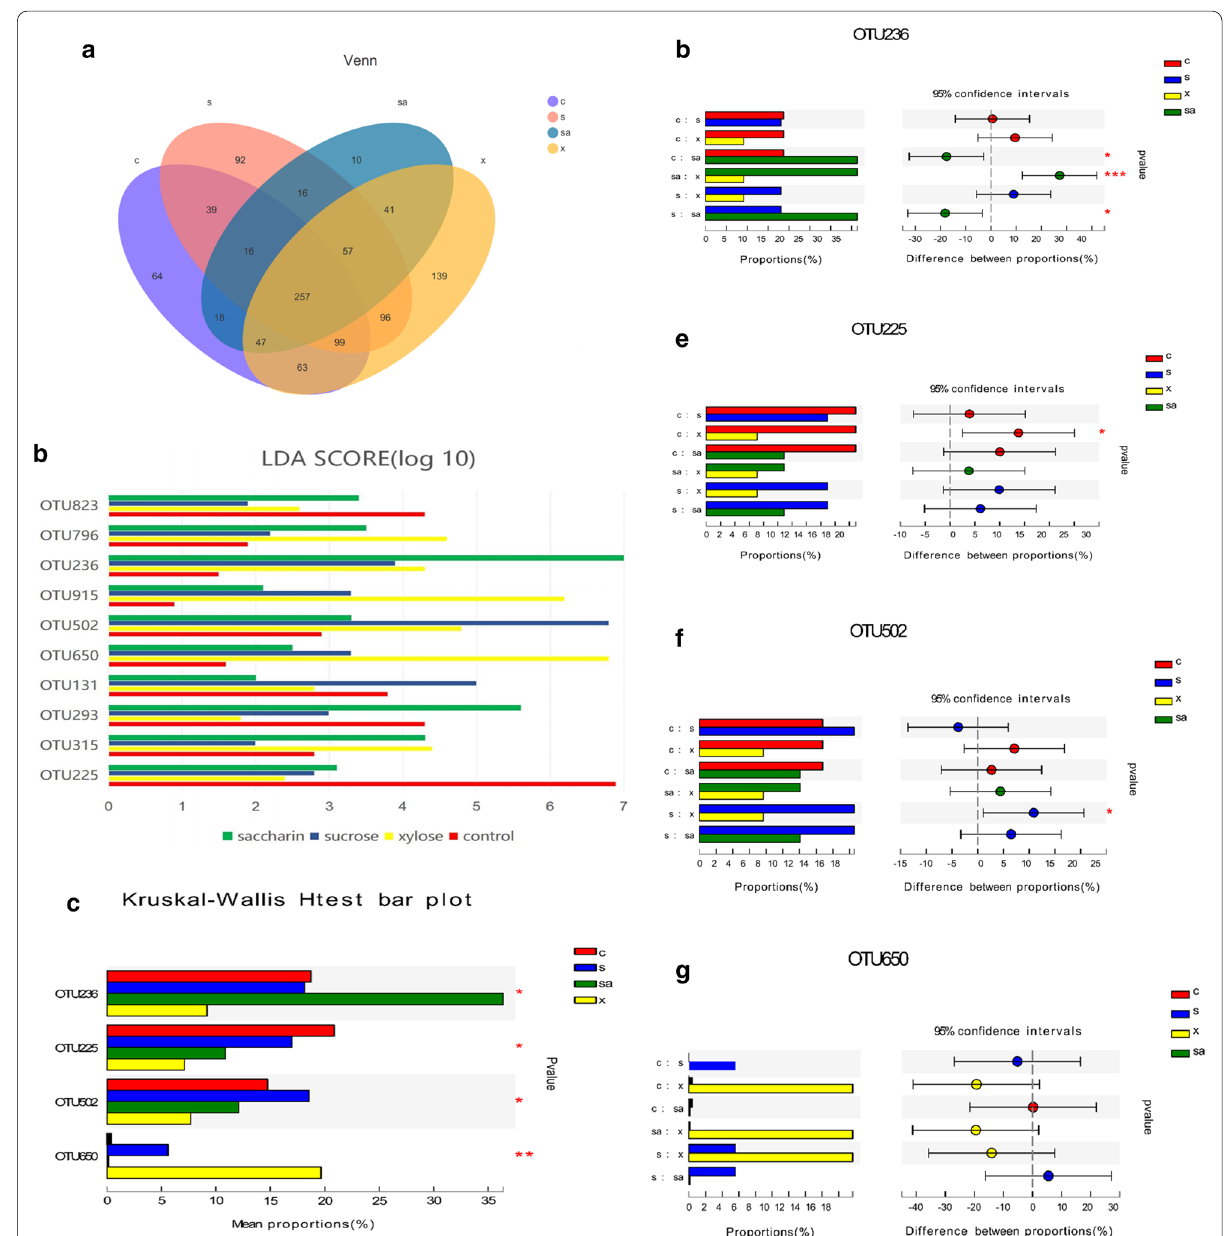
Fig. 3 Unique and shared OTUs in each of the four treatment groups. a Venn diagram showing the shared OTUs (3% distance level) from each of the four groups. b Top ten differentially expressed OTUs identified in the control, xylose, saccharin and sucrose groups identified using linear discriminant analysis coupled with effect size (LEfSe). The distribution of the most differentially expressed OTUs in each group compared in pairs; OTU225, OTU502, OTU650 and OTU236 are illustrated in c , d , e and f , respectively. Four groups: control (c group, red color), xylose (x group, yellow color), sucrose (s group, blue color) and saccharin (sa group, green color) groups. * 0.01 < p